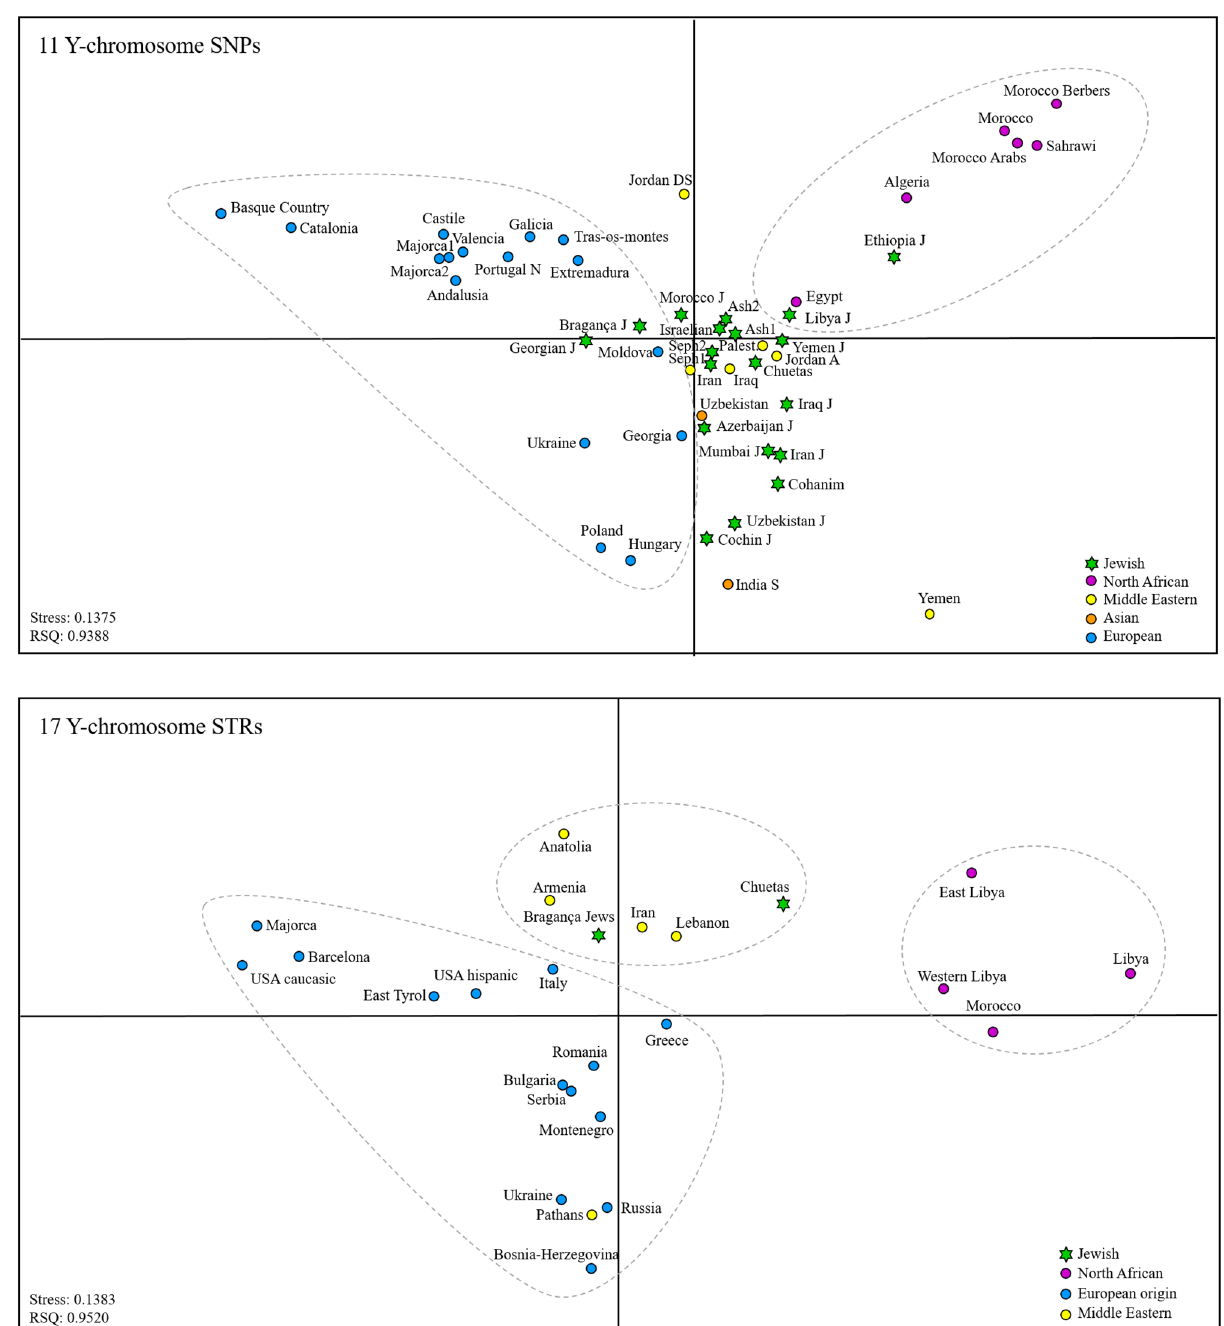
Figure 4. Multidimensional Scaling plot performed with ( a ) 11 SNPs: M1(xM35) E(xE1b1b1), M35 (E1b1b1), M213 (F), M201 (G), M170 (I), 12f2a (J(xJ2)), M172 (J2), M9(xM173) K(xR1), M173(xM17) R1(xR1a1), M17 (R1a1) and a final category for other haplogroups not included in these 10 SNPs and ( b ) Y-filer STRs. Circles defining each population are coloured following the legend code. Jewish populations are labelled with a Star of David. Populations and references are in Supplementary Table